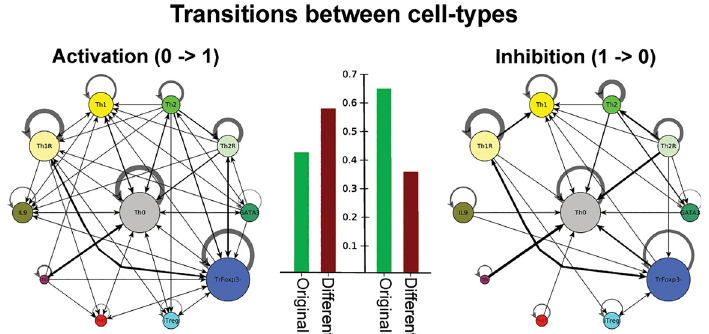
Fig 6. Cell fate map in response to activating or inhibitory signals of the TSRN model. The attractors of the network were transiently perturbed in all possible micro-environments. Perturbations were considered activations (0 ! 1) when a previously inactive element was turned on, and inhibitions (1 ! 0) when a previously active element was turned off. The nodes represent CD4+ T cell types, and the node sizes correspond to the size of the basin of attraction. The edges represent transitions between cell types, the width of the edges correspond to the number of times the transition occurred on the logarithmic scale. The number of transitions towards a different or the original cell type were counted for both activations and